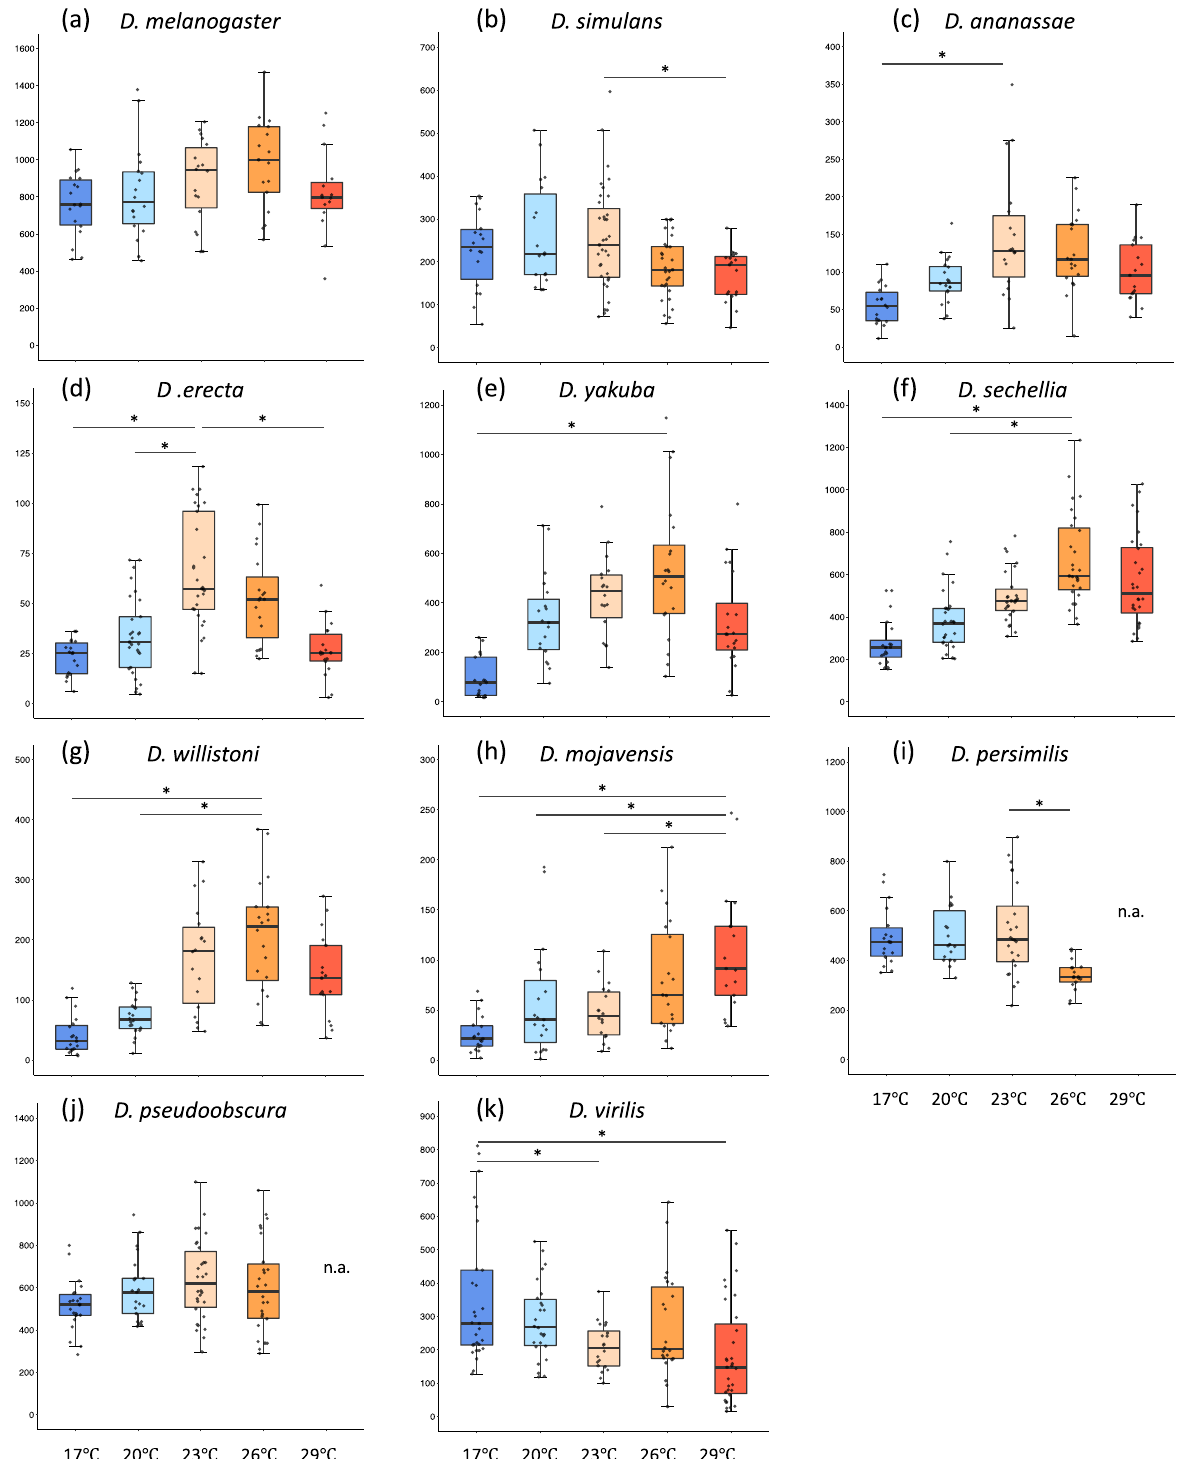
Figure 1. Total daily locomotor activity of 11 Drosophila species at five different temperatures. ( a–k ) The total daily locomotor activity in each species; ( a ) D. melanogaster , ( b ) D. simulans , ( c ) D. ananassae , ( d ) D. erecta , ( e ) D. yakuba , ( f ) D. sechellia , ( g ) D. willistoni , ( h ) D. mojavensis , ( i ) D. persimilis , ( j ) D. pseudoobscura , and ( k ) D. virilis . The y axis shows the activity levels (counts) and x axis shows time of the day. Caution that the y axis range are different among species. The box color indicates experimental temperatures; dark blue:17 °C, light blue: 20 °C, light orange: 23 °C, dark orange: 26 °C, red: 29 °C. Except for D. melanogaster and D. pseudoobscura , all the other species show the significant difference in total locomotor activity among different temperature conditions (Kruskal–Wallis tests, p < 0.05). In this and following figures, each box plot shows the median as the bold line, first and third quartiles as the box boundaries, and 1.5 times of the interquartile ranges as whiskers. Each dot indicates average total daily activity (counts) of individual fly. The horizonal bar with * above the boxes indicates the significant differences in the pairwise-comparison between the highest average of total locomotor activity and others (Bonferroni/Dunn test, p < 0.05). The sample size of each analysis is shown in Supplementary Fig.